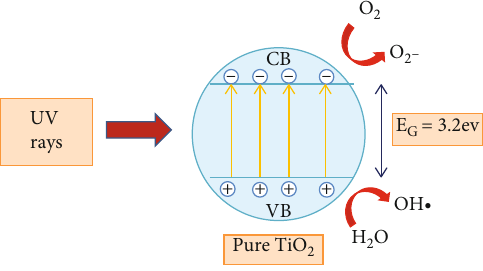
Figure 4: Mechanism of Photocatalytic degradation by TiO